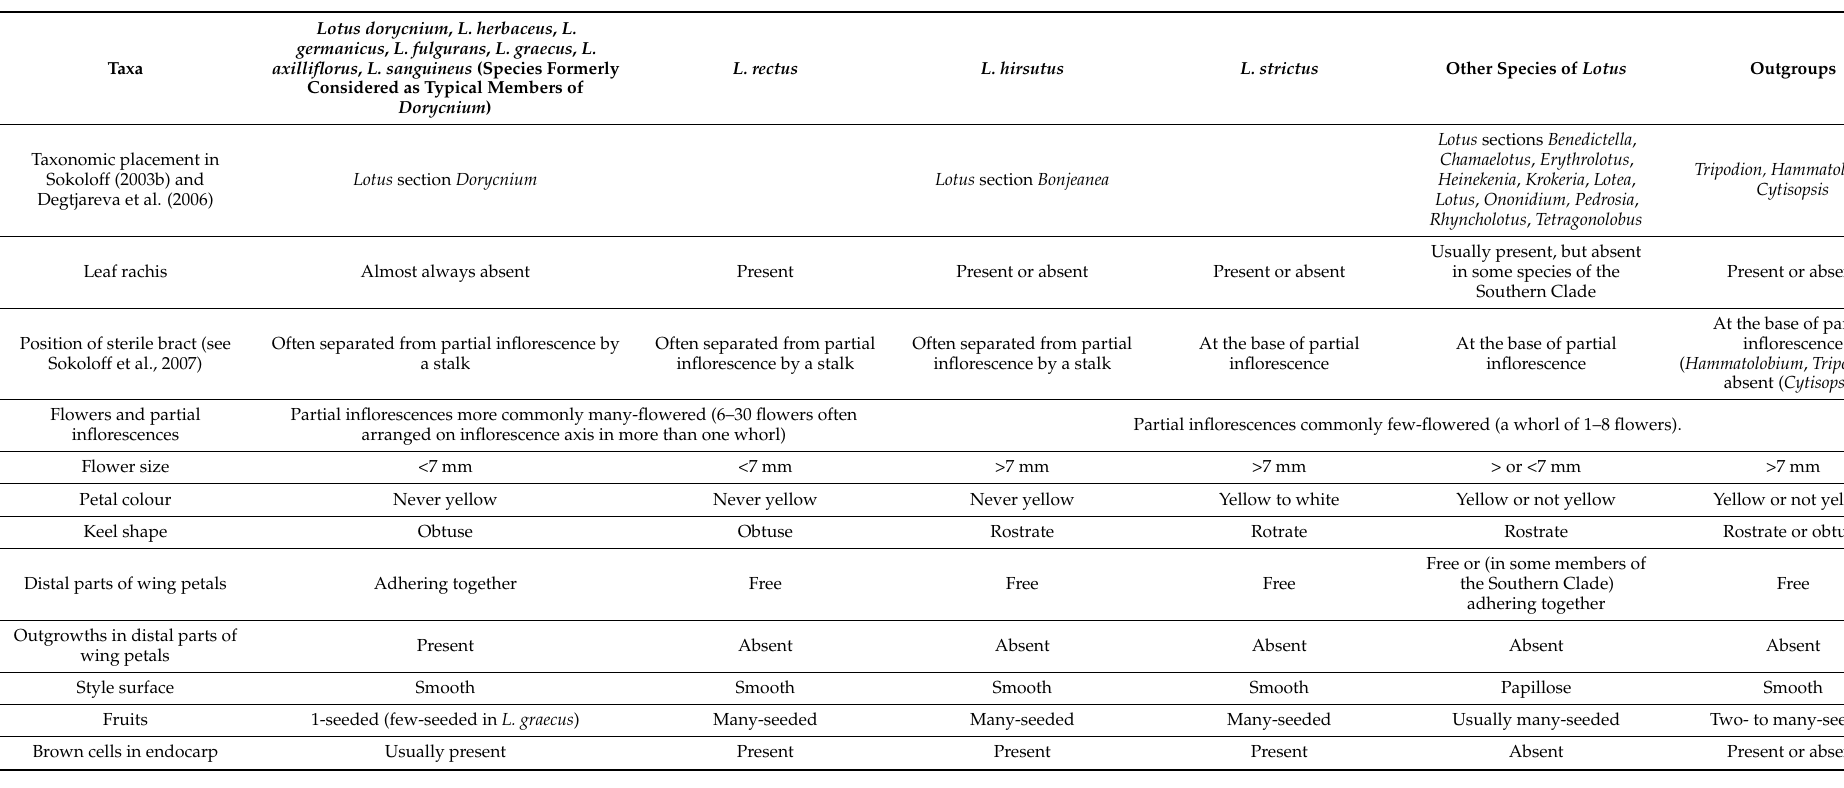
Table 1. Morphological characteristics of Lotus rectus, L. hirsutus , and L. structus compared to those of species traditionally placed in Lotus and Dorycnium